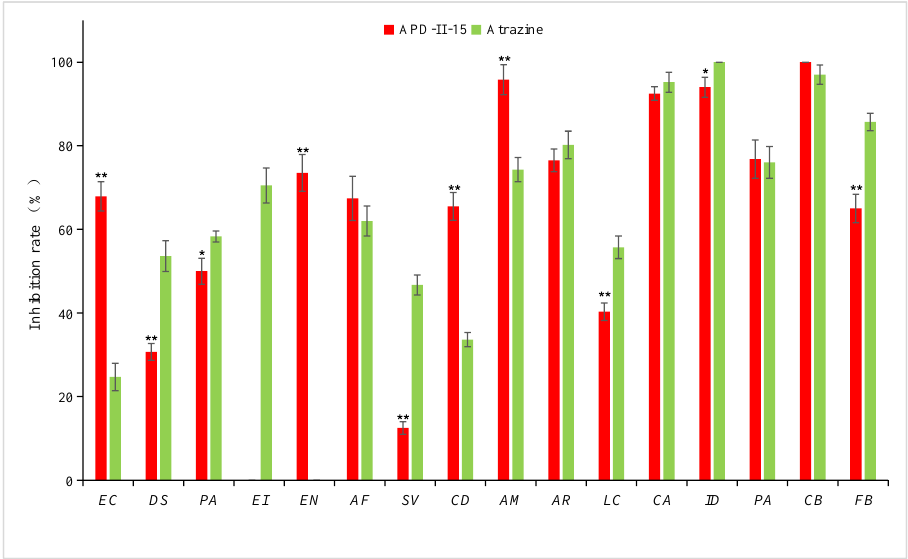
Figure 7. Effects (% inhibition) of the target compound APD-II-15 and atrazine on loss of plant weight at a dosage of 187.5 g ha − 1 after treatment at 14 days under the pre-emergence conditions. Abutilon theophrasti Medicus (AM), Amaranthus retroflexus L. (AR), Echinochloa crus-galli (EC) Digitaria sanguinalis (L.) Scop. (DS), Poa annua L. (PA), Eleusine indica (EI), Eragrostis curvula (Schrad.) Nees (EN), Avena fatua L. (AF), Setaria viridis (L.) Beauv. (SB), Cyperus difformis L. (CD), Leptochloa chinensis (L.) Nees (LC), Chenopodium album L. (CA), Ixeris denticulata (ID), Plantago asiatica L. (PA), Capsella bursa-pastoris (Linn.) Medic (CB), Flaveria bidentis (L.) Kuntze (FB); Asterisk (*) means significant differences between different treatments. *, significant at the p < 0.05 level, and **, significant at the p < 0.01 level compared with